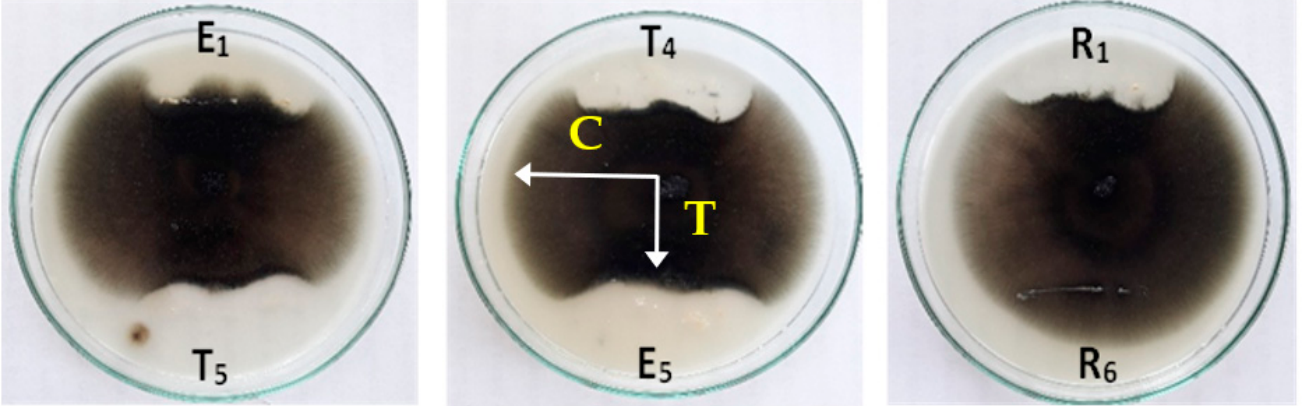
Figure 2. Dual culture plate method showing inhibition of radial growth of Helminthosporium sp. by different isolates of endophytic bacteria, where C is the growth of fungus toward the control side of the Petri dish and T is the outward growth of the fungus in the direction of the antagonistic bacteria. Table 2. Antagonistic activity of selected endophytic bacterial isolates against Helminthosporium sp. and Alternaria sp. in